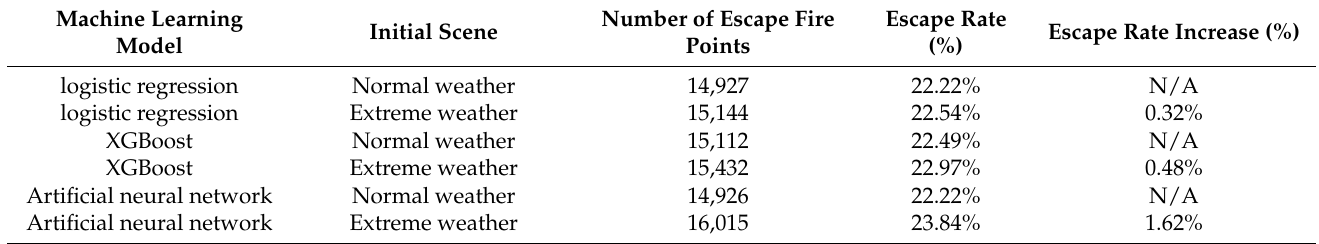
Table 3. Comparison of Simulation Initial Attack Results in Different